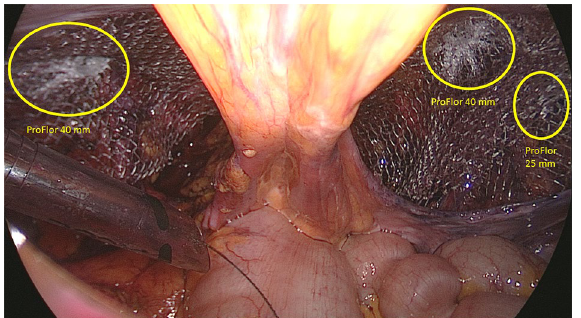
Figure 7. Panoramic view of the lower posterior abdominal wall dissected for TAPP repair of bilateral groin hernias. On the left side an indirect hernia has been obliterated with a 40 mm ProFlor. On the contralateral groin a concomitant double ipsilateral hernia defect (one in the medial inguinal fossa and one in the lateral fossa) has been managed by delivering one 40 mm ProFlor in the direct defect and one 25 mm in the indirect defect. The flat parts of all three devices completely cover the inguinal and femoral areas of both groins.